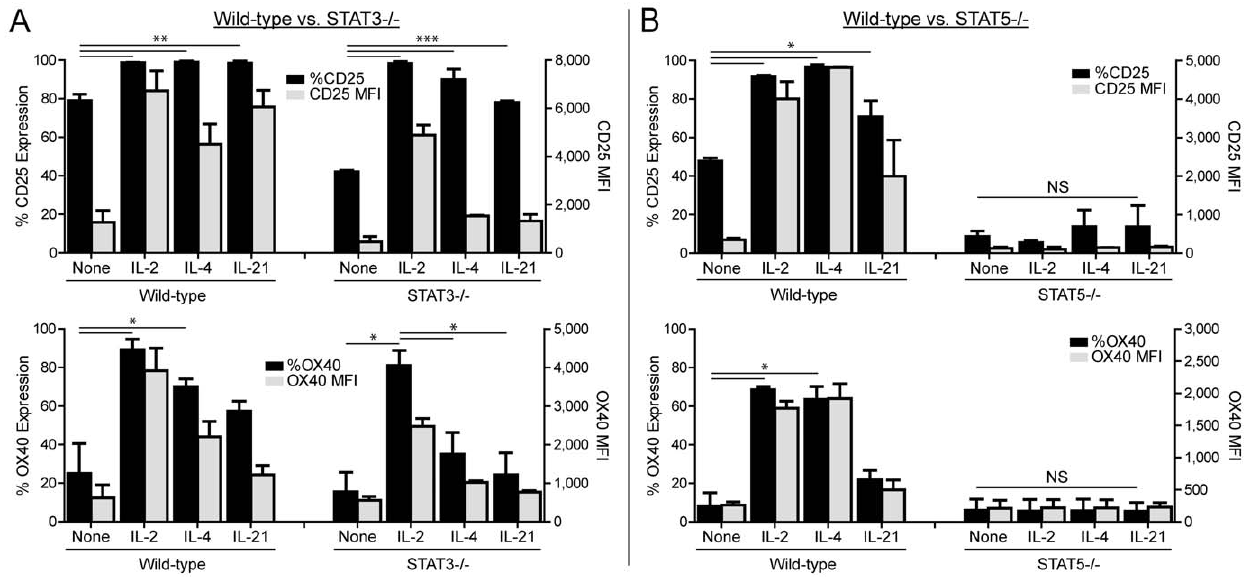
Figure 4. STAT3 and STAT5 are required for optimal up-regulation of OX40 following stimulation with common gc cytokines. A ) WT or STAT3 2 / 2 OT-I T cells were stimulated for 2 days, harvested, and then re-cultured with media alone, rmIL-2, rmIL-4, or rmIL-21 (100 ng/ml); 24 hours later cells were harvested and the extent of CD25 and OX40 expression (% positive and MFI) were measured. B ) Polyclonal endogenous WT or STAT5 2 / 2 CD8 T cells were stimulated for 2 days with 2 mcg/ml anti-CD3 mAb, harvested, and then re-cultured with media alone, rmIL-2, rmIL-4, or rmIL-21 (100 ng/ml) and then 24 hours later, cells were harvested and the extent of CD25 and OX40 expression (% positive and MFI) were determined. A, B ) Bar graphs depict the mean + / 2 SD (n=2–3/group). Data are representative of one out of two independent experiments. *P , 0.05; ** P , 0.01; *** P , 0.001; NS=no statistically significant difference.